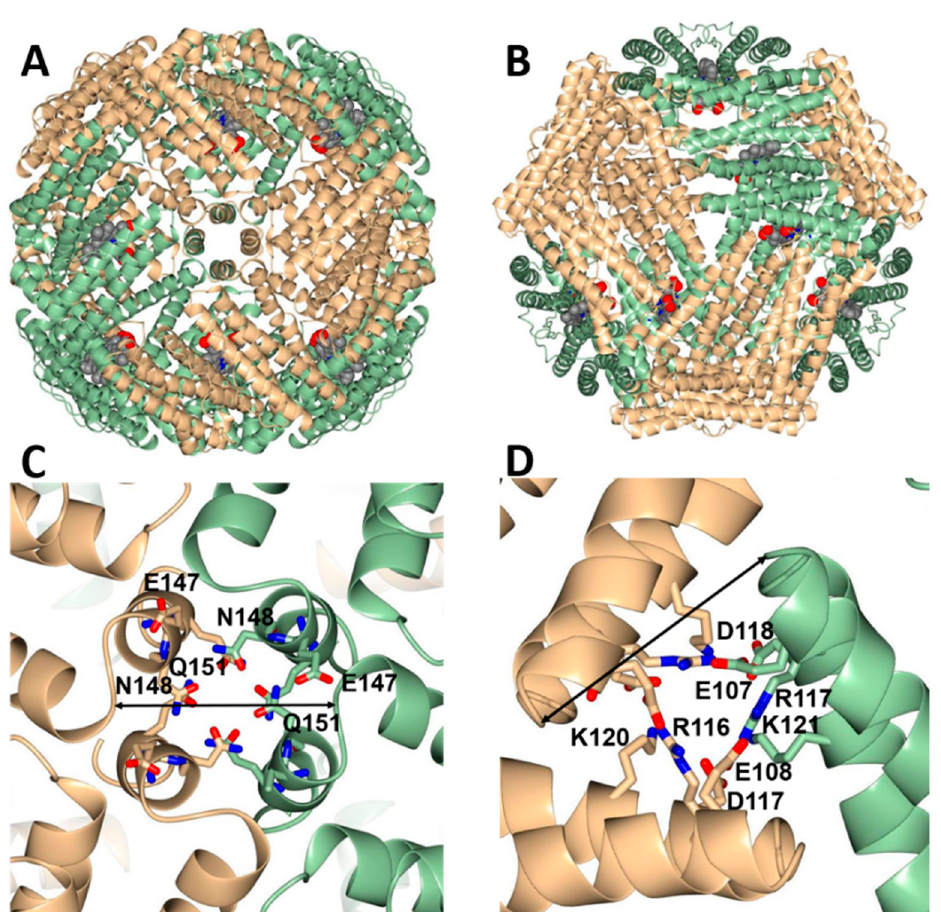
Figure 7. In silico model showing one of the possible arrangements in which six FtnA inter-subunit dimers (wheat) and six BfrB inter-subunit dimers (green) assemble into a 24-mer Bfr. Heme (red) is contained between each BfrB inter-subunit dimer. ( A , B ) views of the heterooligomeric 24-mer Bfr viewed along a four-fold and a three-fold pore, respectively. ( C , D ) are close-up views of the corre- sponding three-fold and four-fold pores, which are nearly indistinguishable from the corresponding pores in the structures of FtnA rec (PDB ID 3R2K) and BfrB rec (PDB ID 5D8O) used in the model con- struction (see text). The distances across the four-fold and three-fold pore are 17 and 16 Å, respec- tively and are indicated by the arrows in ( C , D ).